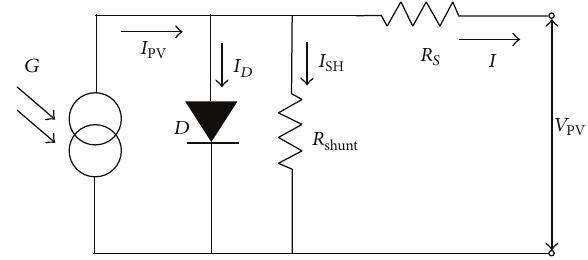
Figure 2: Equivalent circuit model of PV cell. effect on the open circuit voltage whereas the temperature variation affects the open circuit voltage and the short circuit current varies very